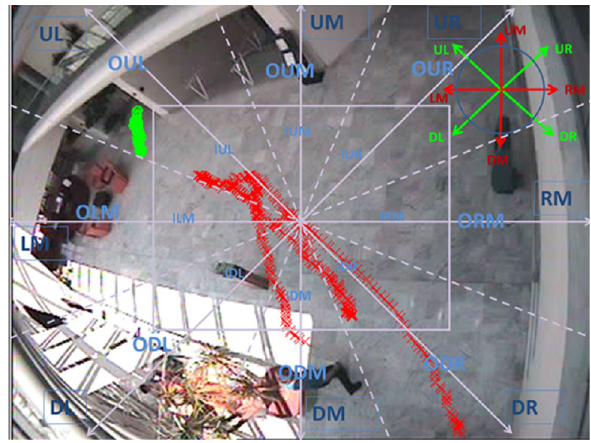
Fig. 4 An example of a key frame, over which we show the eight directions (in red and green) and the sixteen areas. We can also see the trajectories (object1 in red, object2 in green). Scene “LeftBox”, CAVIAR dataset